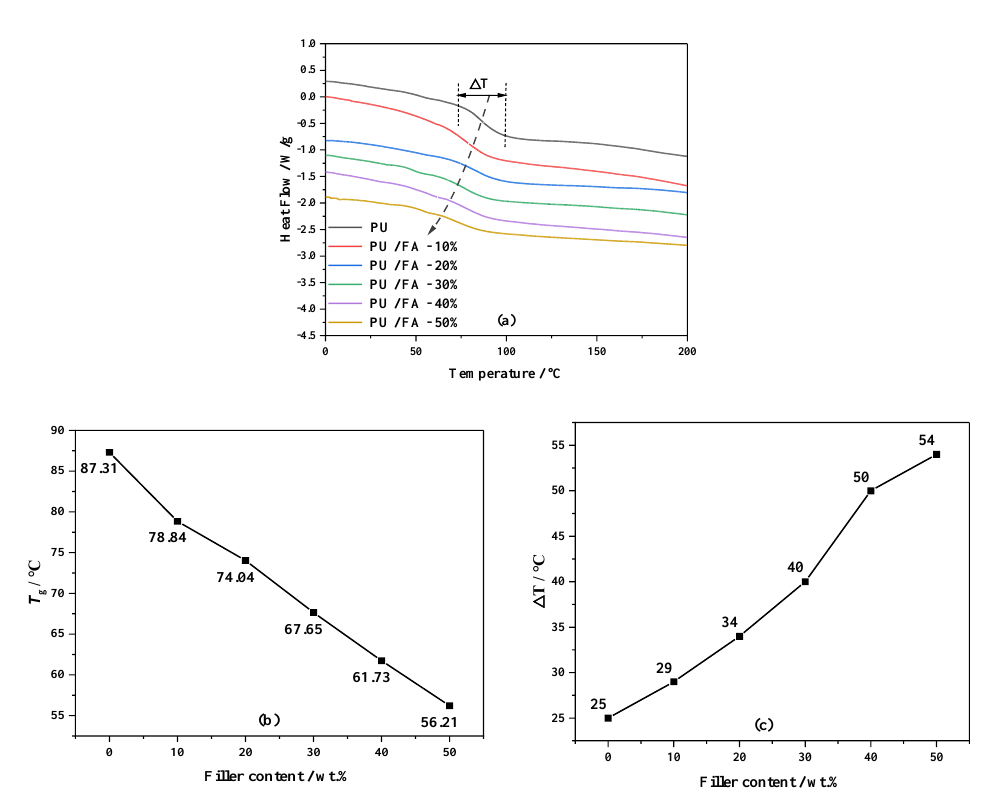
Figure 7. The DSC curve ( a ); T g ( b ); ∆ T ( c ) of PU and PU/FA composites.